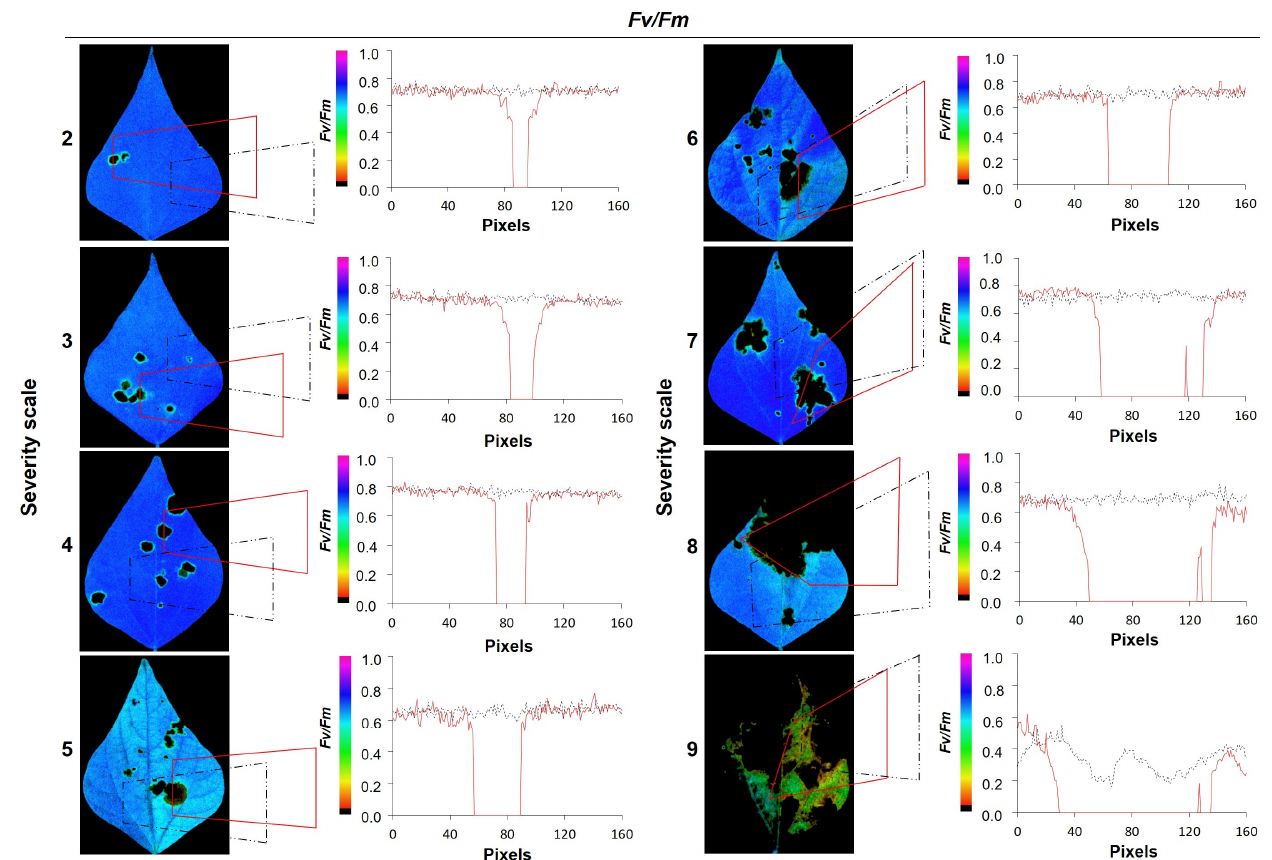
Figure 2. Measurement of F v /F m along the transects for each severity scale of web blight on common bean leaves in healthy and affected areas. Subfigures 2 to 9 represent severity scale numbers. The right side of each image shows the changes in F v /F m along the plotted zones; the solid red line shows “affected zones” and the dashed black line shows “apparently unaffected zones.” The color gradient from violet to red or black indicates the F v /F m values, where healthy zones range from blue to violet, and affected zones range from green to black.